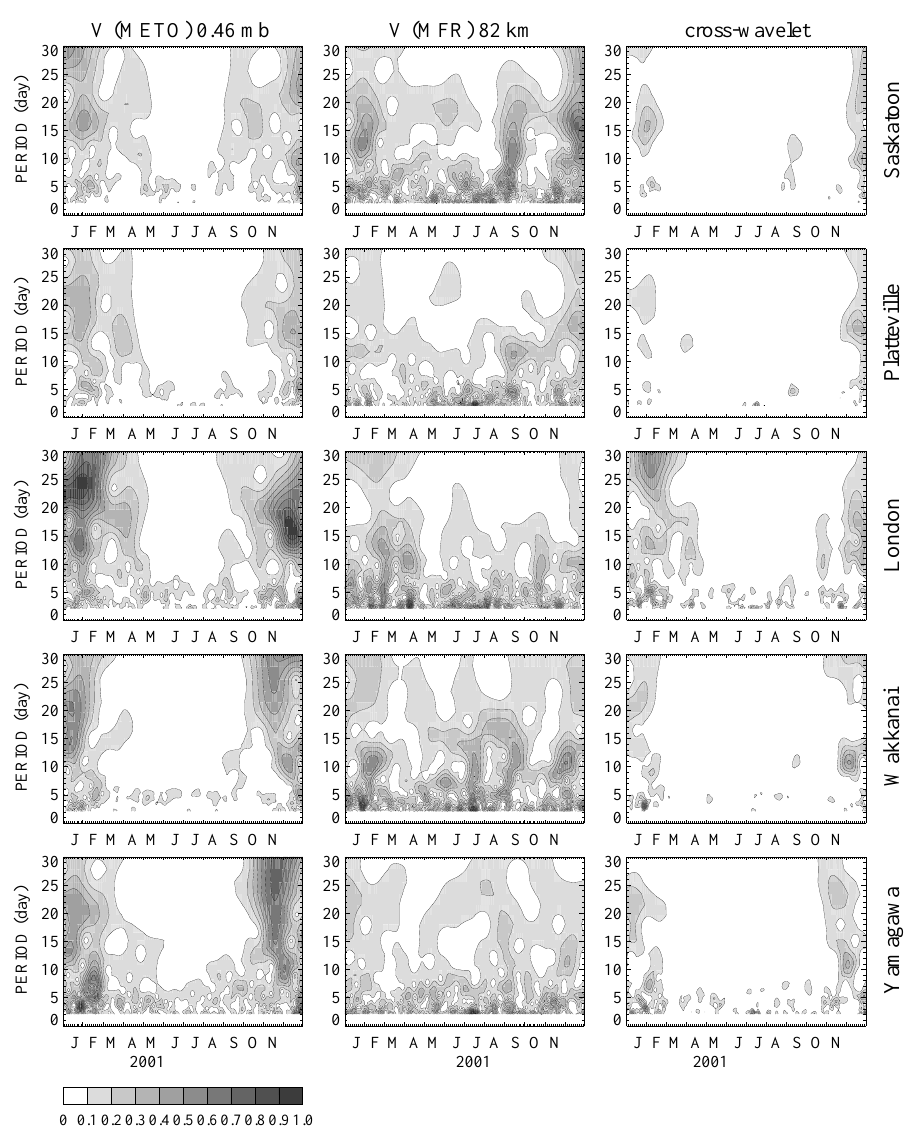
Fig. 6. ( a ) The self-normalized wavelet amplitudes versus time (2001 year) and period (2–30 days) calculated for the meridional component (V) of the MetO winds at 0.46mbar (the left column) and MF radar winds at 82km (the center column), and their cross-products (the right column) are presented for all five CUJO locations. From the top to the bottom these are for Saskatoon, Platteville, London, Wakkanai, and